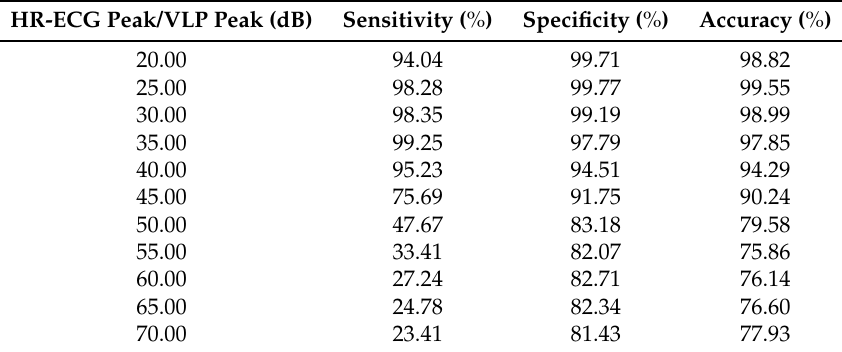
Figure 10. CAD performance plot in terms of HR-ECG peak to VLP peak ratio. Table 1. Achieved